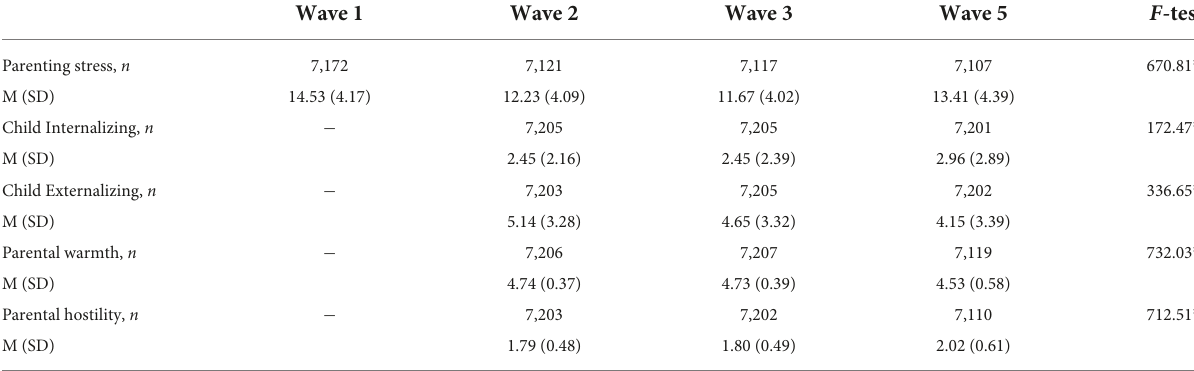
TABLE 3 Means and standard deviations of parental stress scores, child internalizing, child externalizing, parental warmth, and parental hostility of wave 1, 2, 3, and 5. Wave 1 Wave 2 Wave 3 Wave 5 F